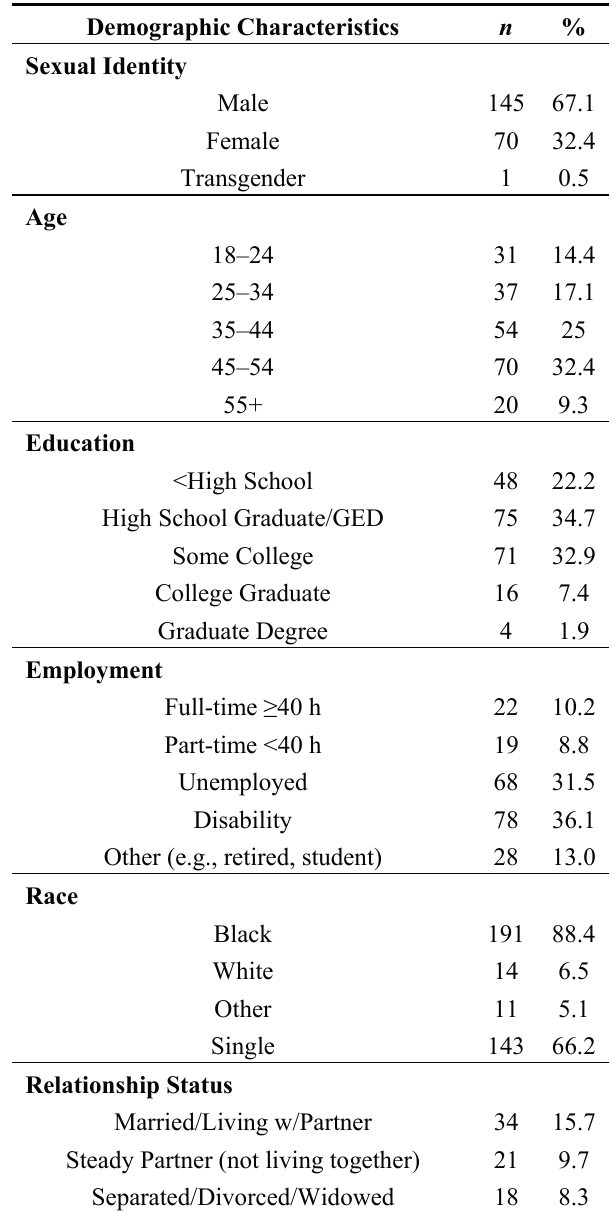
Table 1. Demographic Characteristics for Respondents who Received ARVs within the Past 12 Months ( n =